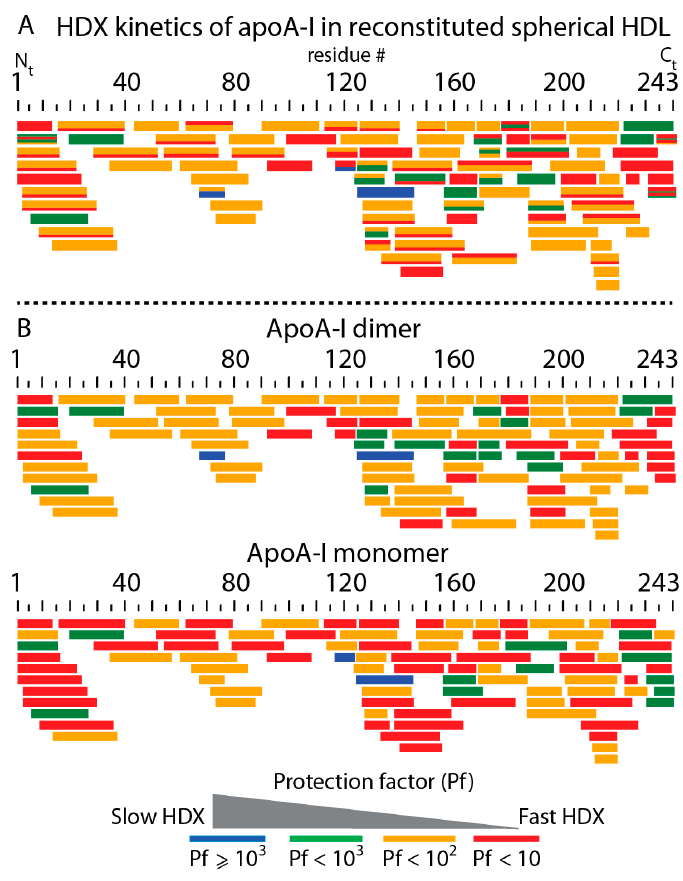
Figure 4. Map of all overlapping digested apoA-I peptides observed in the HDX-MS experiments. ( A ) Peptides were depicted as colored bars; bicolor bars represent peptides with bimodal HDX kinetic behavior. The thickness of colored stripes in a bar was proportional to the peptide’s relative abundance. ( B ) Digested peptides, displaying bimodal HDX kinetics, were grouped in two pools: the top bar chart shows the set of digested peptides predicted to originate from an apoA-I dimer. The peptides were color-